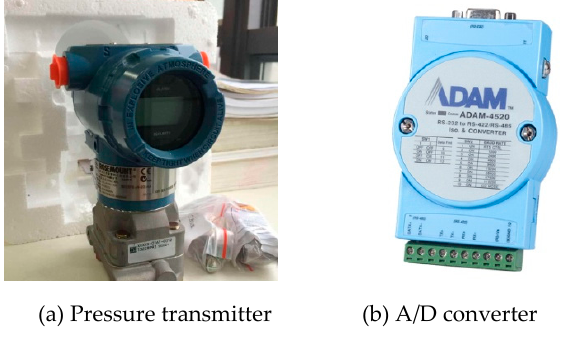
Figure 9. Pressure transmitter and A/D converter.